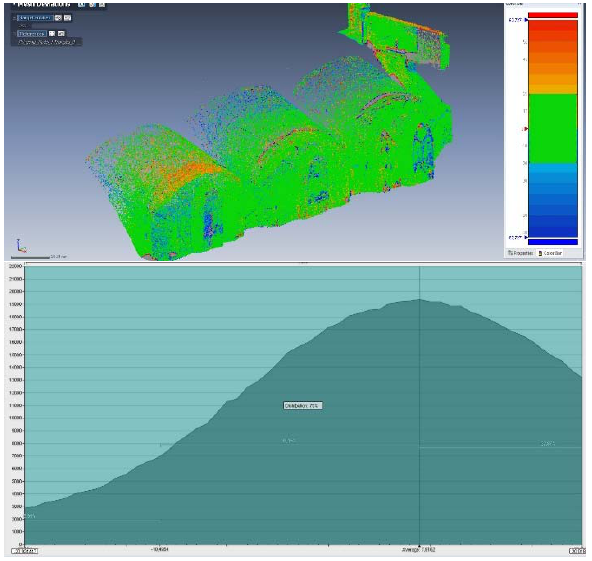
Figure 12. Graphic and numerical deviation between